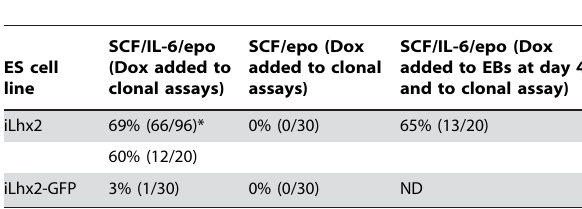
Table 1. Efficiency in generating DoxHPC lines from individual colonies in clonal assays of EB